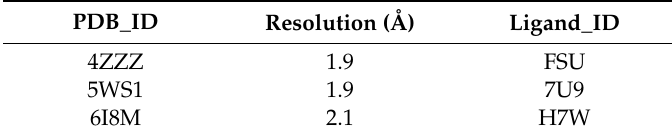
Table 1. Basic information of receptor–ligand complexes of the PARP-1 catalytic domain from the PDB